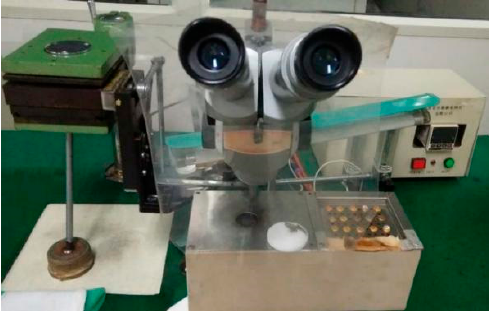
Figure 1. Deep-cavity eutectic soldering table.